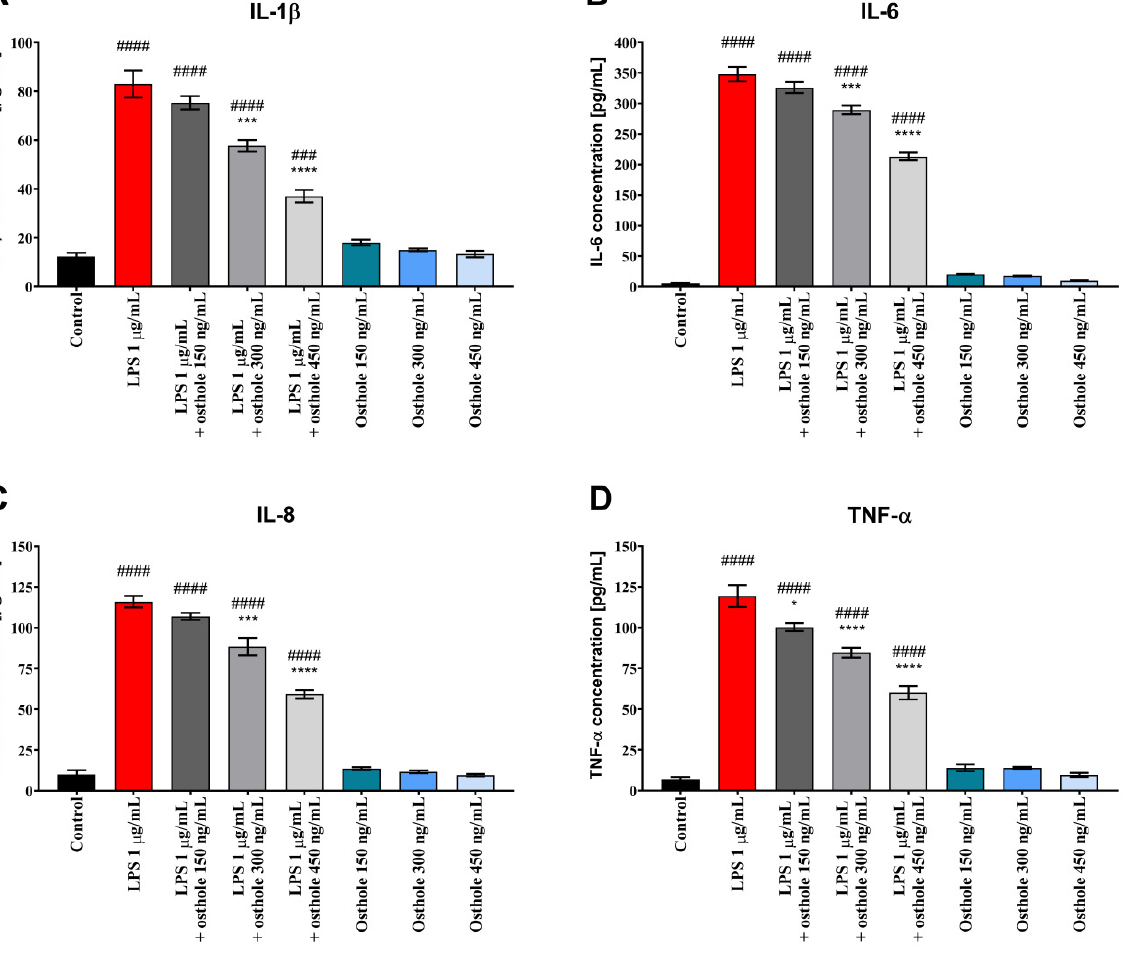
Figure 2. The level of IL-1 β ( A ), IL-6 ( B ), IL-8 ( C ) and TNF- α ( D ) after incubation of Caco-2 cells with LPS (1 µ g/mL), osthole (150–450 ng/mL) and its mixtures. Horizontal line shows mean and bars depict standard error of mean. Statistically significant differences in comparison to control (###— p < 00.01, ####— p < 0.0001) and to cells treated with LPS (*— p < 0.05, ***— p < 0.001, ****— p < 0.0001) are marked.